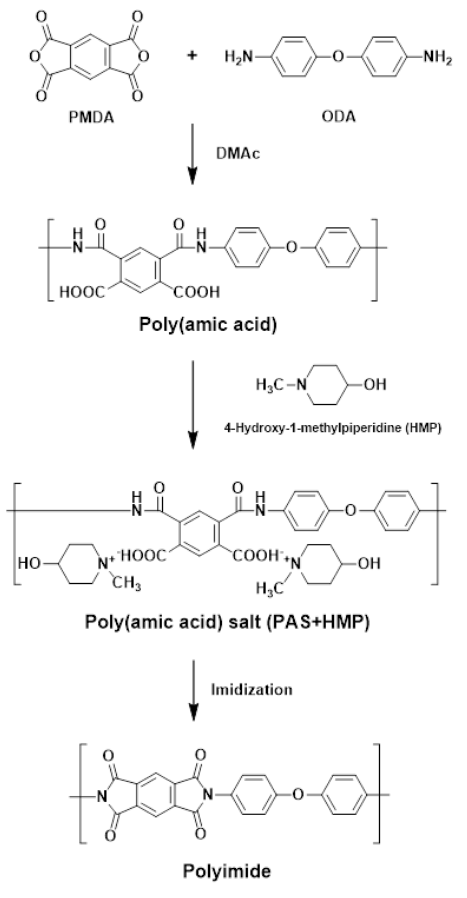
Figure 1. Synthetic route for PAS.